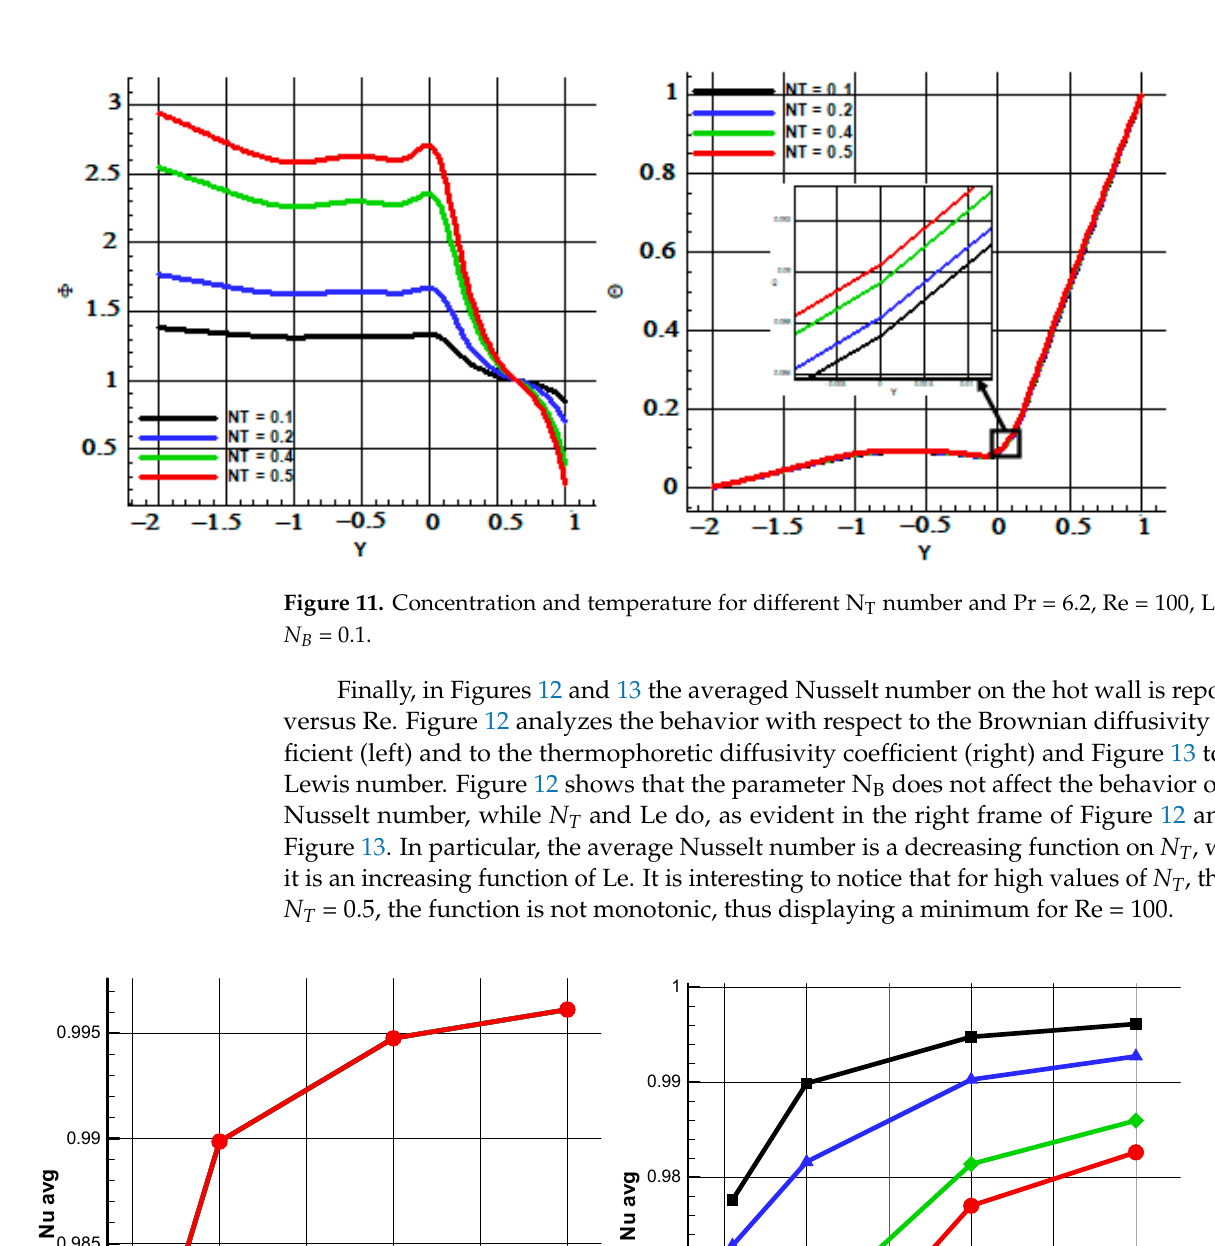
Figure 10. Concentration and temperature for different N B number and Pr = 6.2, Re = 100, Le = 1, N T = 0.1.